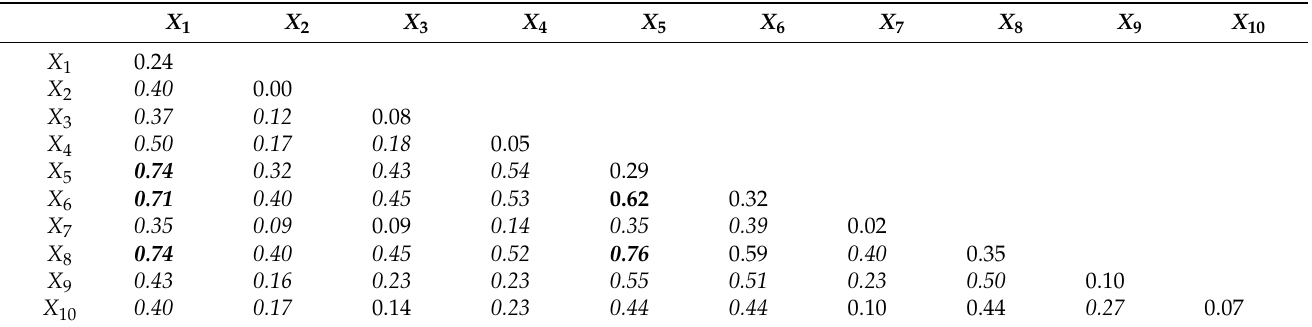
Table 7. Interaction detector of village management digitalization index.